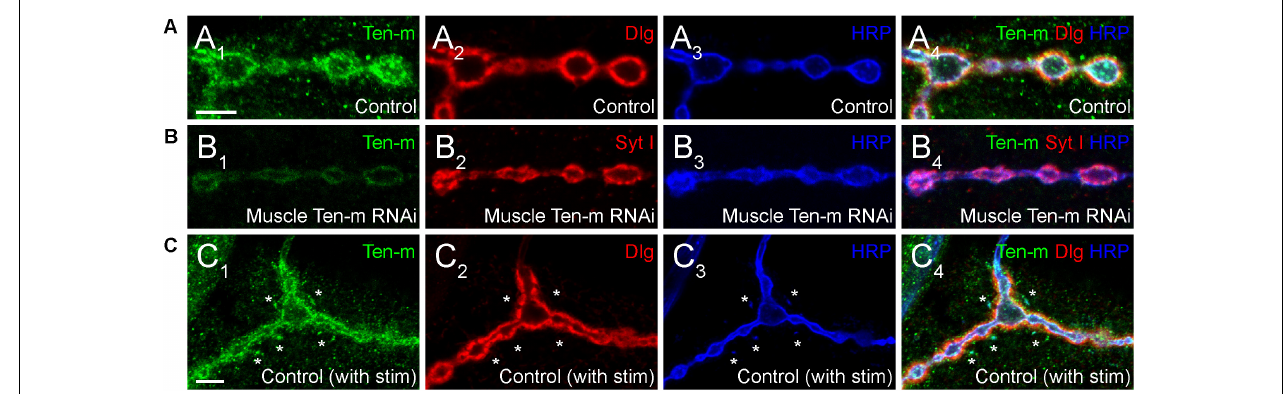
FIGURE 4 | Presynaptic Ten-m localizes to newly formed synaptopods. Single confocal sections of NMJs stained with antibodies to Ten-m (green), Dlg (red), and HRP (blue, in A , C ) or Ten-m (green), Syt I (red), and HRP (blue, in B ). Control NMJs show predominantly postsynaptic Ten-m localization (A) but a presynaptic component associated with the HRP-positive membrane and synaptic vesicle (via Syt I) population is visible upon genetic removal of the postsynaptic pool of Ten-m (B) . Following spaced stimulation, Ten-m (green) is visible within newly formed synaptopods (marked by asterisks) that have not yet been apposed by postsynaptic Dlg (red) staining. Scale = 5 µ